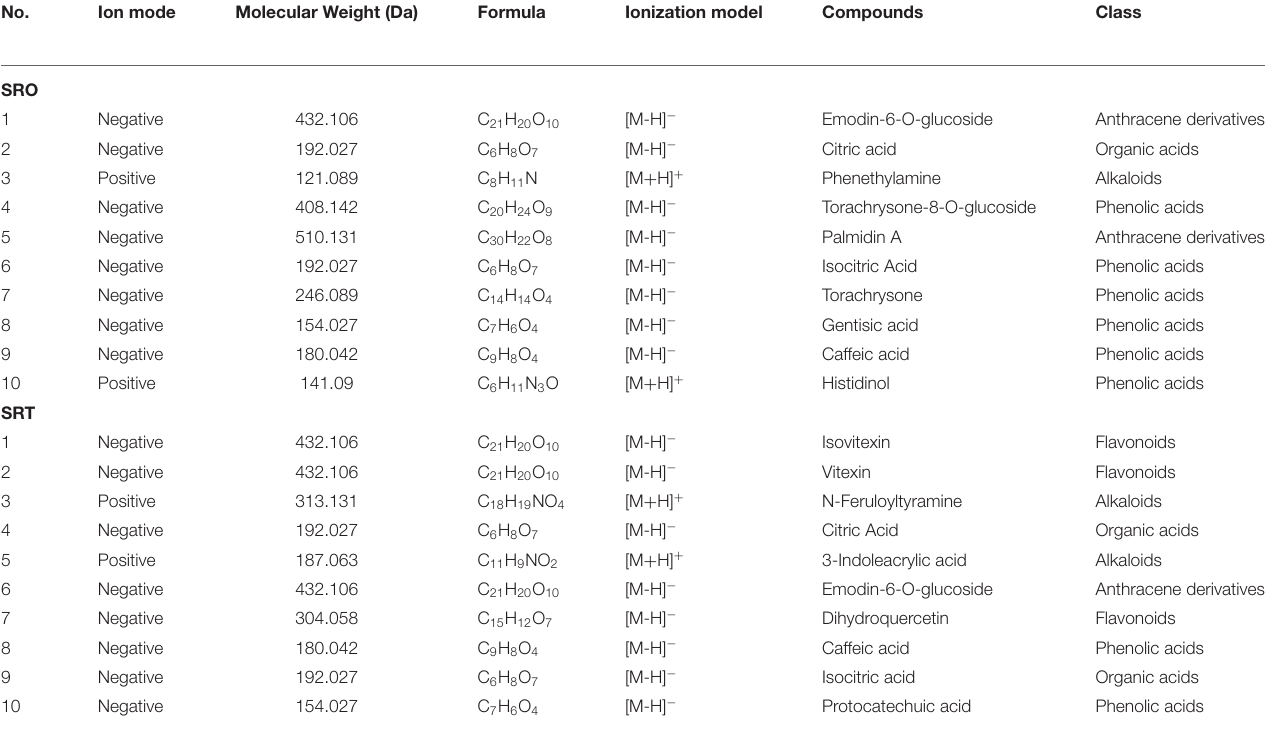
TABLE 2 | Top ten compounds identified from SRO and